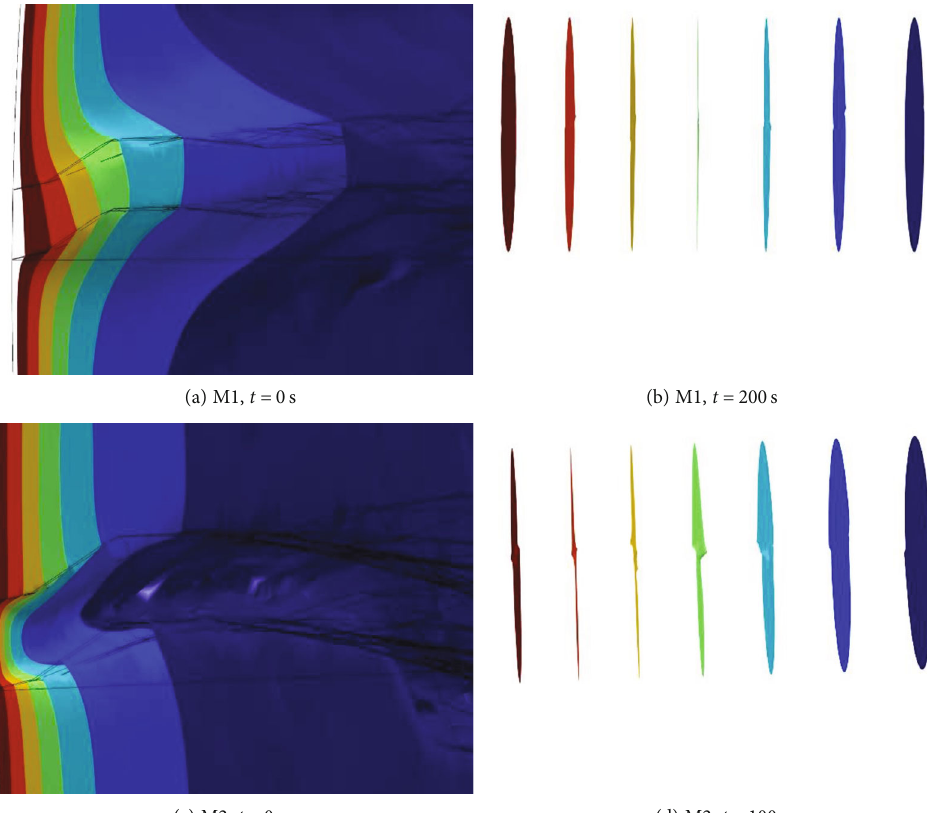
Figure 8: Isosurfaces of the pore water